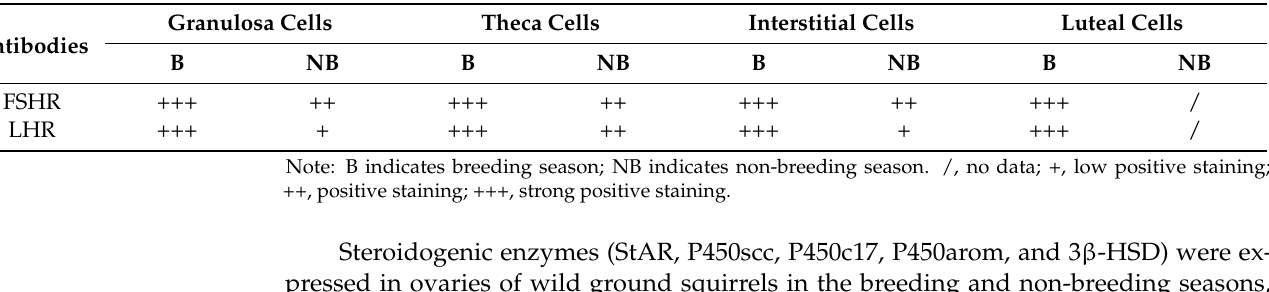
Figure 3. Immunolocalizations of FSHR ( a – c ) and LHR ( d – f ) during the breeding season ( first two columns ) and the non-breeding season ( third column ). Negative control of two periods represented in the last row ( g – i ). The gene expression levels of Fshr ( j ) and Lhr ( k ) in the breeding and non-breeding periods ( n = 3 for each group). Abbreviations: B represents the breeding season; NB represents the non-breeding season; GC represents granulosa cells; TC indicates theca cells; IC indicates interstitial cells; LC represents luteal cells. Bar, 40 µ m. The error bars represent means ± s.e.m. ** represented p < 0.01. Table 2. Relative abundance of target proteins of FSHR and LHR in the ovaries of wild ground squirrels during the breeding and non-breeding seasons.